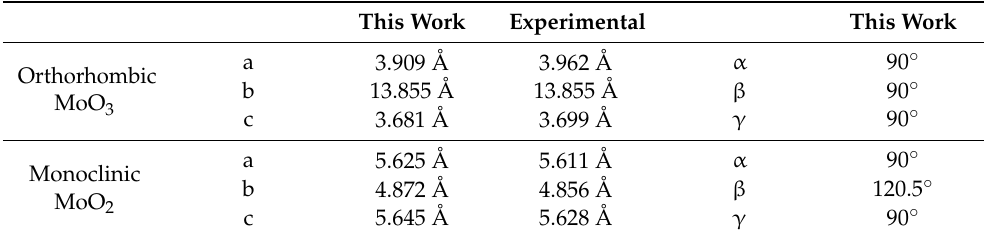
Table 1. Comparison between our theoretical results and experimental lattice vectors [47,48] for